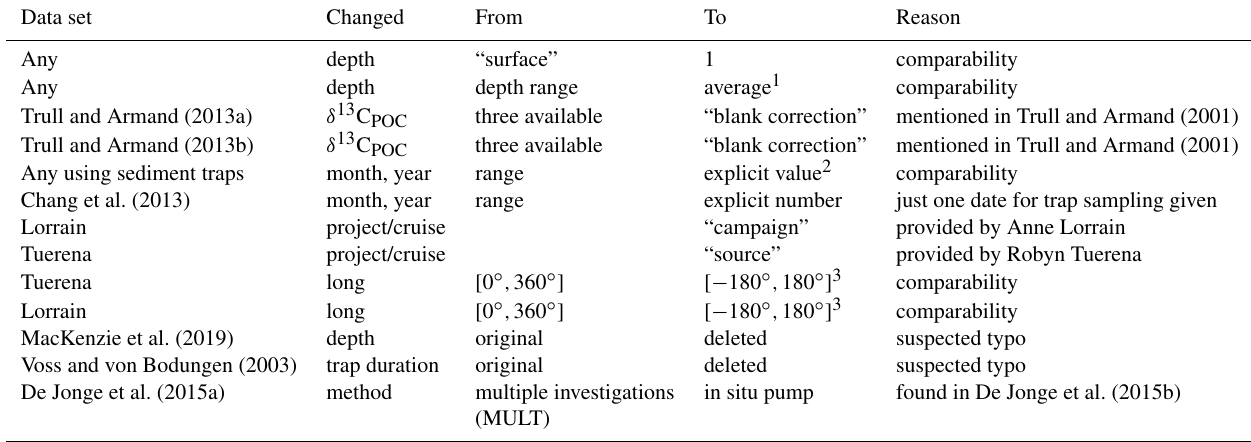
Table 2. Changes made in other data: this table’s structure is equivalent that of to Table 1. It refers to all changes made in general and any data other than the Goericke (1994)